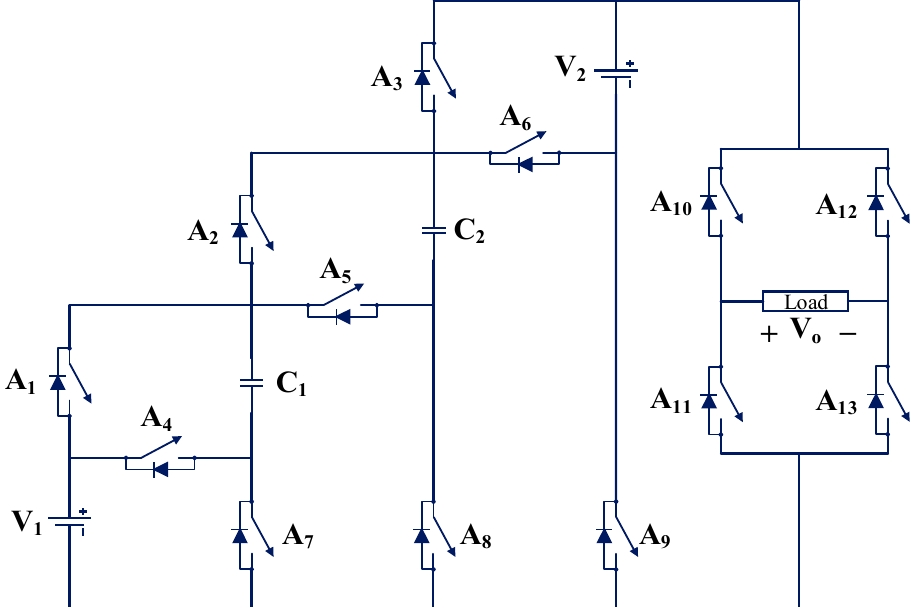
Figure 42. Single-phase nine-level FT MLI (TP45) [77].